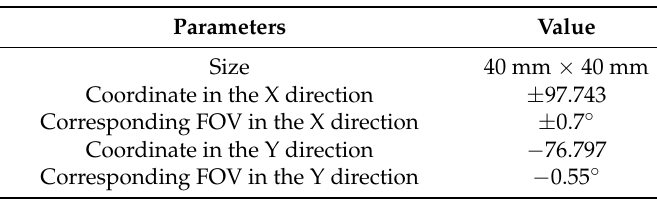
Table 3. Parameters of the dichroic filter component.